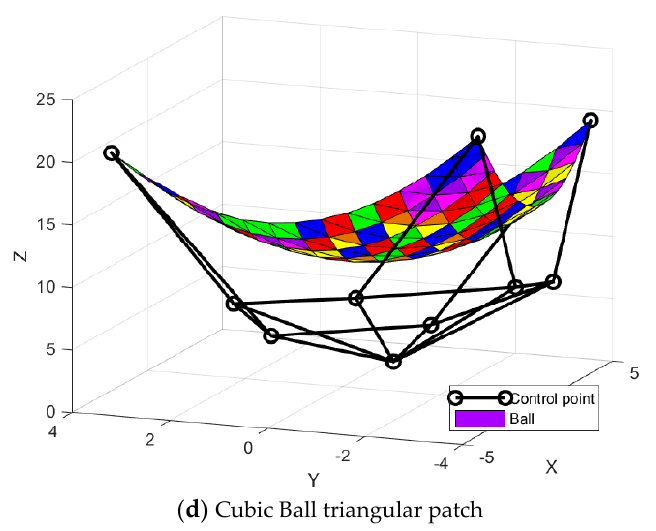
( d ) Cubic Ball triangular patch Figure 4. Surface interpolation. Figure 4. Surface